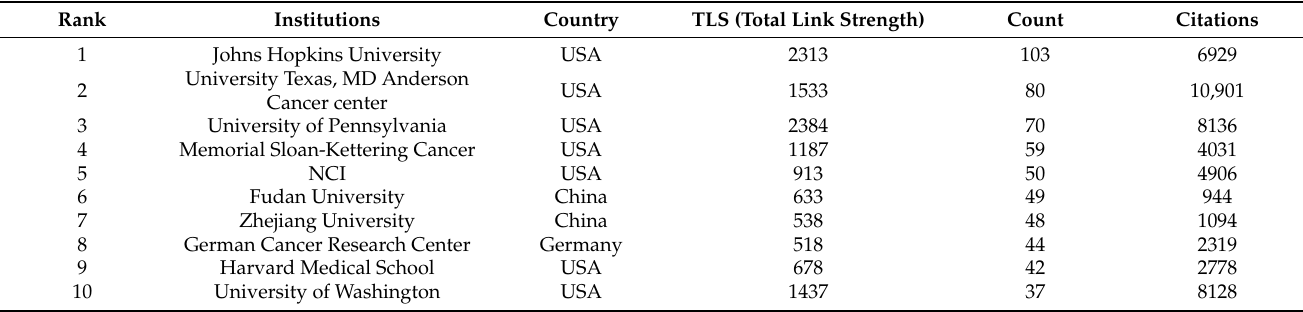
Table 2. Top 10 productive